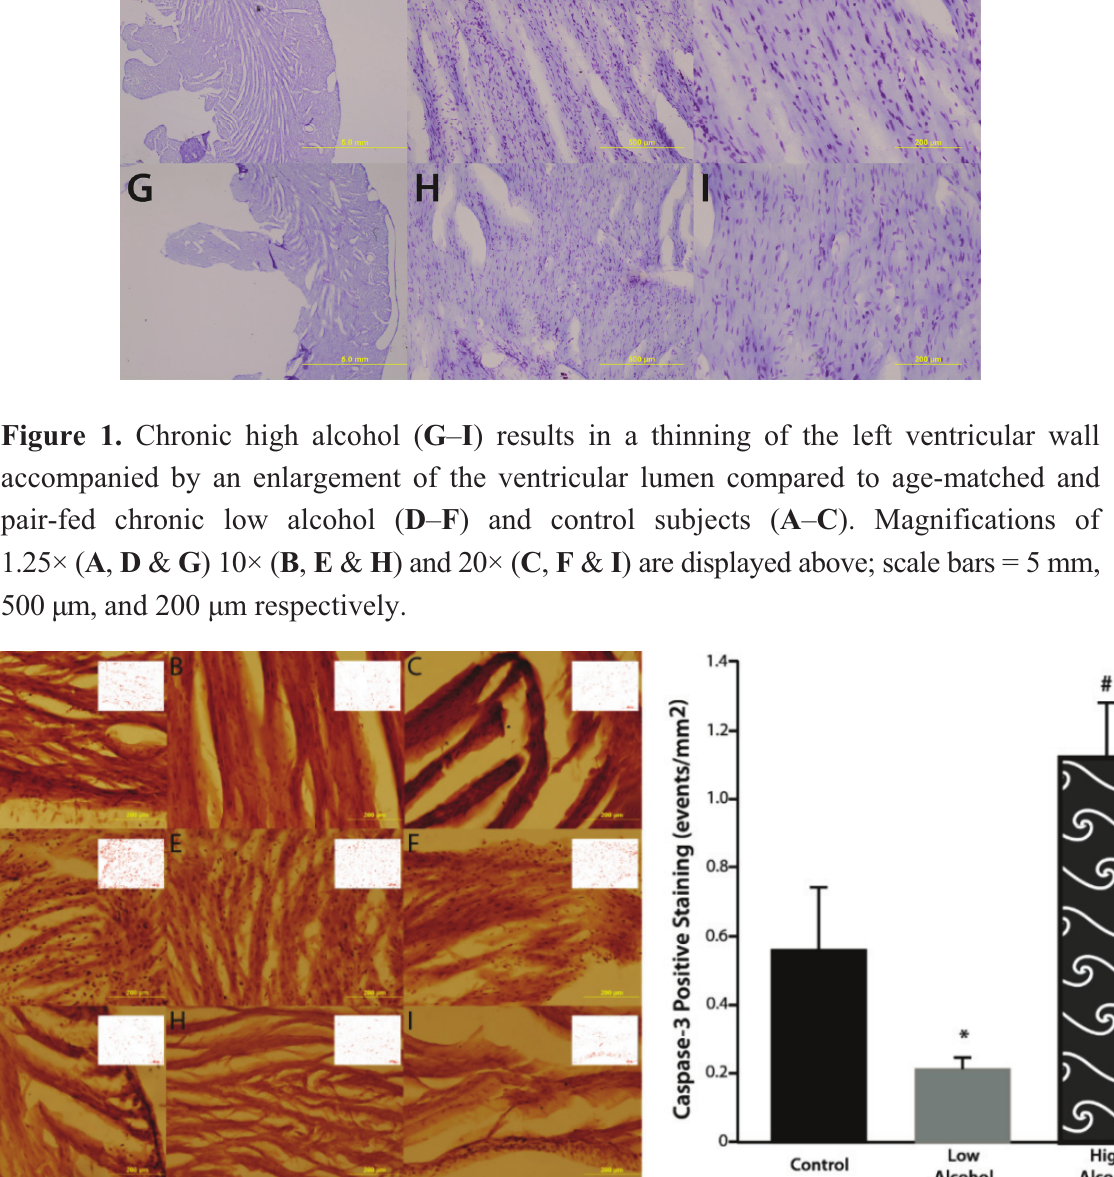
Figure 2. There is significantly elevated caspase positive events in the high alcohol group ( D – F ) compared to controls ( A – C ) and low alcohol animals ( G – I ) in the epicardial ( A , D , G ), myocardial ( B , E , H ), and endocardial ( C , F , I ) layers. Low alcohol ( G – I ) displayed significantly lower caspase positive events compared to both high alcohol ( D – F ) and controls ( A – C ). ImageJ-generated profiles are inset on each image. Magnification of 20× are displayed above; scale bar = 200 (cid:2)m. * p < 0.05 compared to control and HA; # p < 0.05 compared to control and